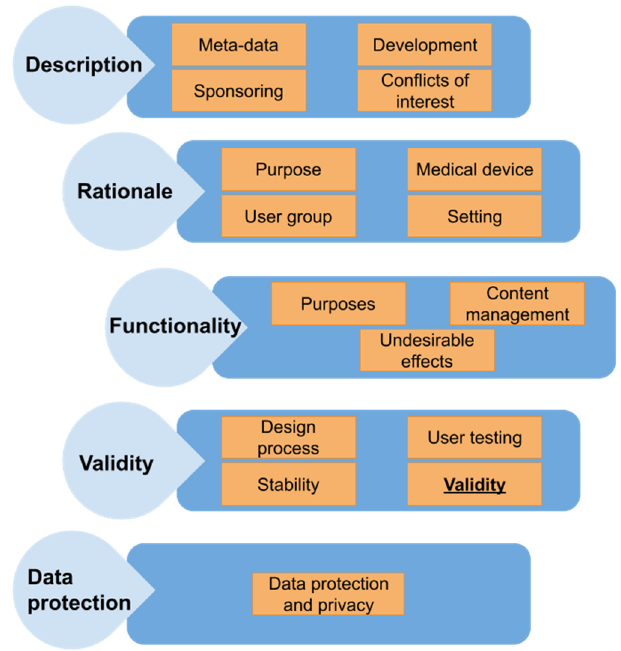
Figure 1. Themes and categories from the assessment framework.